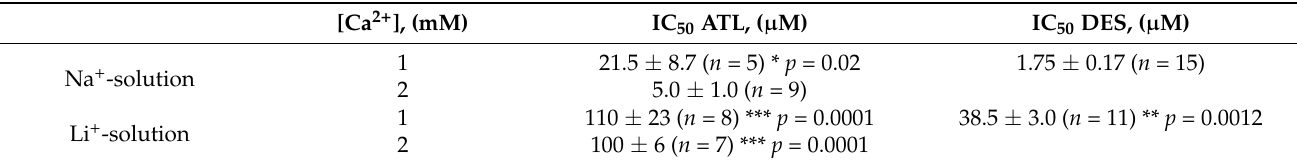
Figure 1. Modulation of amitriptyline (ATL) inhibition of NMDAR currents by Ca 2+ is prevented by Li + . ( A ) Examples of currents activated by 100 μM NMDA + 30 μM Gly recorded at −70 mV in the presence of 1 or 2 mM Ca 2+ in the bathing solution in the absence of ATL (0) and the presence of rising ATL concentrations ([ATL]) indicated by numbers at the corresponding level of currents (in μM). Currents normalized to the steady -state amplitude without ATL in control and in 144 mM [Li + ] (full substitution of Na + for Li + ) are shown. ( B ) Concentration – inhibition curves for ATL of currents activated by 100 μM NMDA + 30 μM Gly recorded at −70 mV in the presence of different [Ca 2+ ]s in the bathing solution for control conditions and for 144 mM extracellular [Li + ]. Symbols show mean values ± S.E.M of the relative amplitudes of currents (I b /I c ) in the presence (I b ) and absence (I c ) of different [ATL]s. Solid lines are the fits to the data with the Hill equation. ( C ) The IC 50 s for ATL inhibition of NMDAR currents in control bathing solution and Li + -solution, obtained at 1 and 2 mM of extracellular [Ca 2+ ]. In control conditions, data for 1 mM [Ca 2+ ] differ significantly from those for 2 mM [Ca 2+ ] (*, p = 0.02, one-way ANOVA). Data from each experiment (symbols) and mean values ± S.E.M. are shown. Table 1. An effect of substitution of extracellular Li + for Na + on IC 50 values for inhibition of NMDAR currents by ATL and DES.